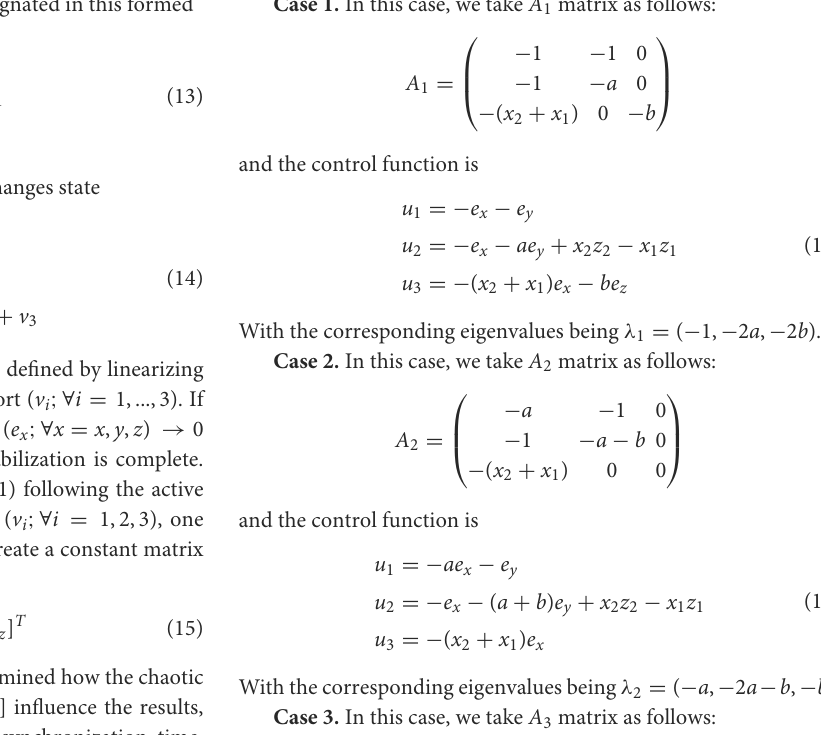
y , y z , and z x plane, which are shown in the 2D phase portrait for the − − −